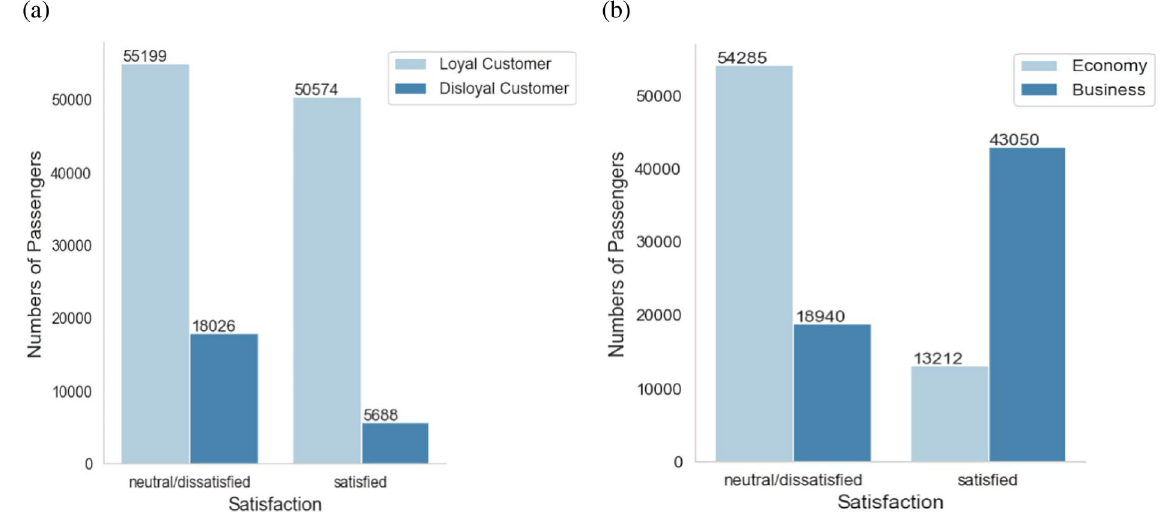
Figure 8. Distribution of people by customer type: ( a ) by passenger type; ( b ) by customer